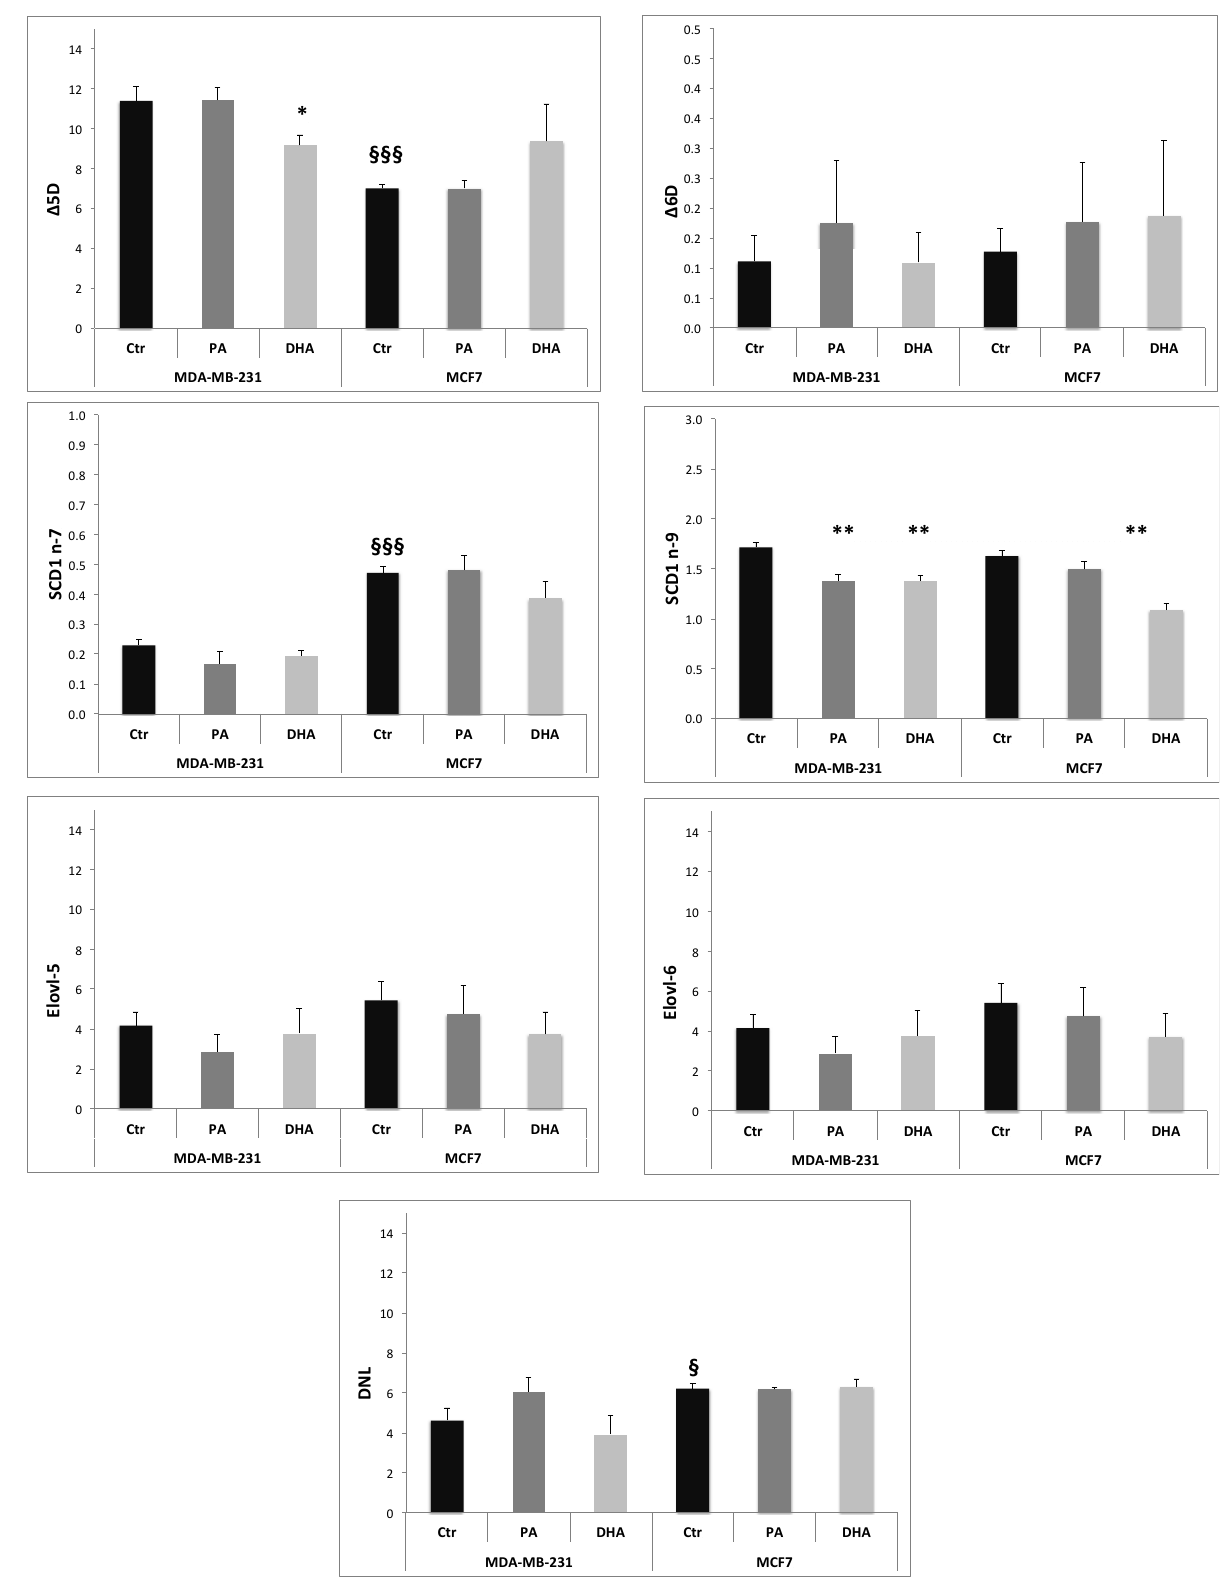
Figure 7. Activities of enzymes involved in fatty acid metabolism, estimated using product-to-precursor fatty acid ratios: The data are expressed as mean ± SE. * p < 0.05 and ** p < 0.01, vs. own Ctr; § p < 0.05 and §§§ p < 0.001 vs. MDA-MB-231 Ctr.